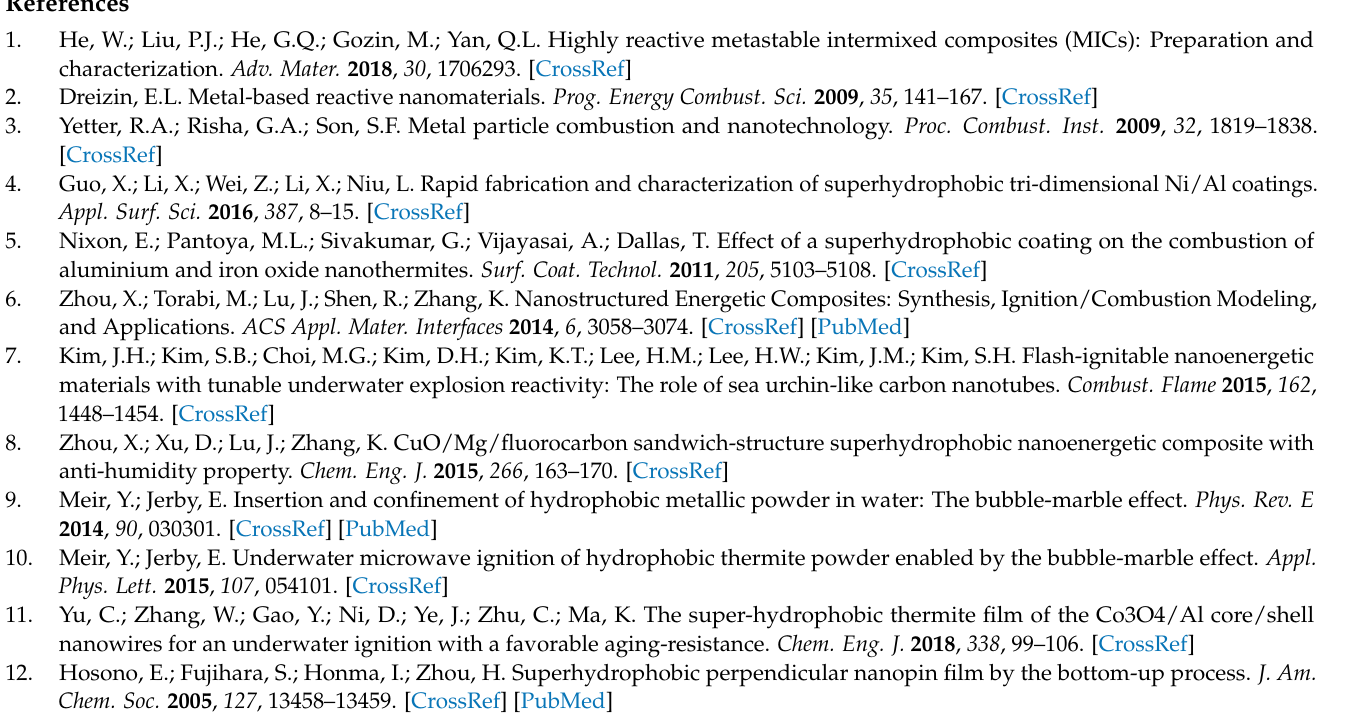
Figure S2: Digital photographs of Al NPs, M-Al/PVDF and I-Al/PVDF films before and after aging